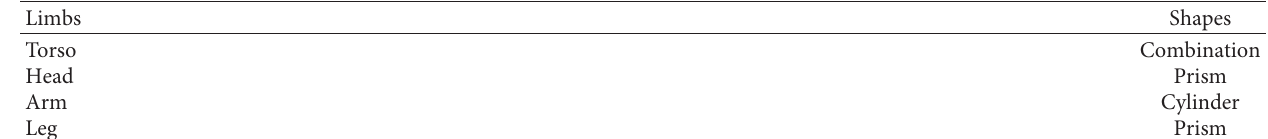
Table 16: The reference human body